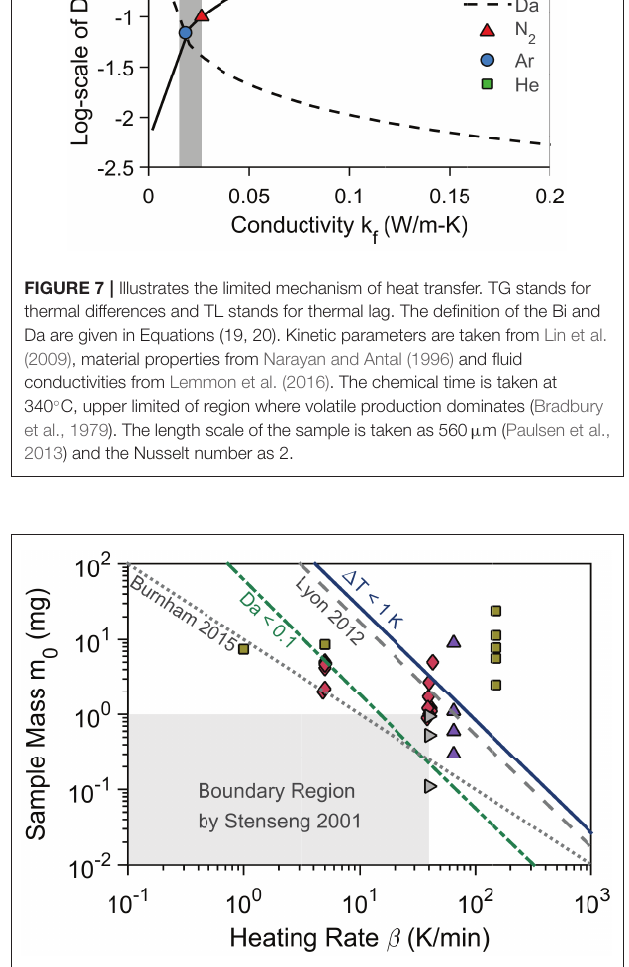
FIGURE 8 | Summary of derived and literature thresholds for transport limitations together with high-quality experiments. The threshold by Burnham et al. (2015) ( m c 10 /β ) is for both intra-and interparticle heat transfer. The = threshold Da < 0.1 (Equation 21) is for interparticle heat transfer with log T s 2.5 0.047log β . The threshold by Lyon et al. (2012) = + ( m